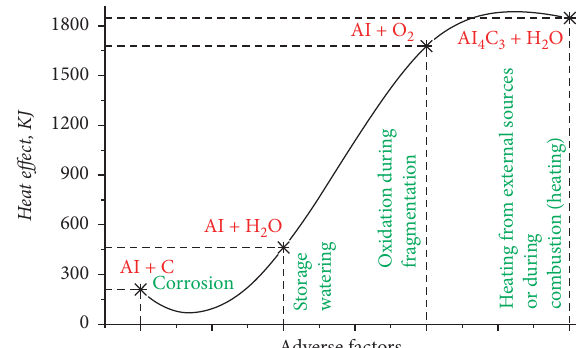
Figure 9: Dependence of the thermal effect of chemical reactions on factors capable of initiating them.